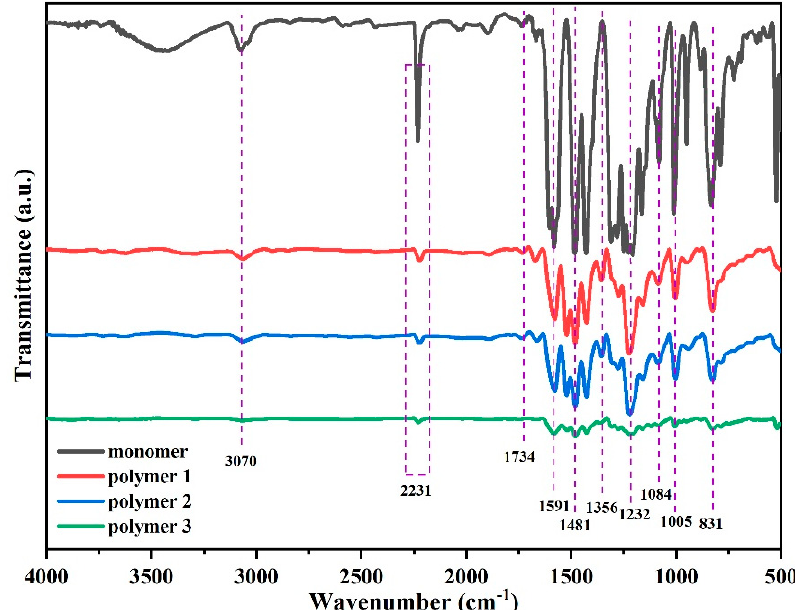
Figure 6. FT-IR spectra of DPTP monomer and polymers.